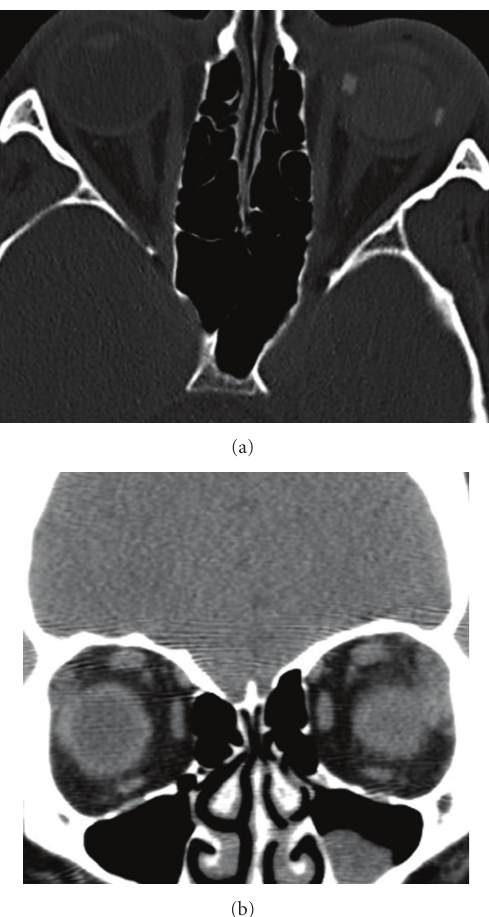
Figure 3: Orbital CT scan showing no residual intraocular foreign